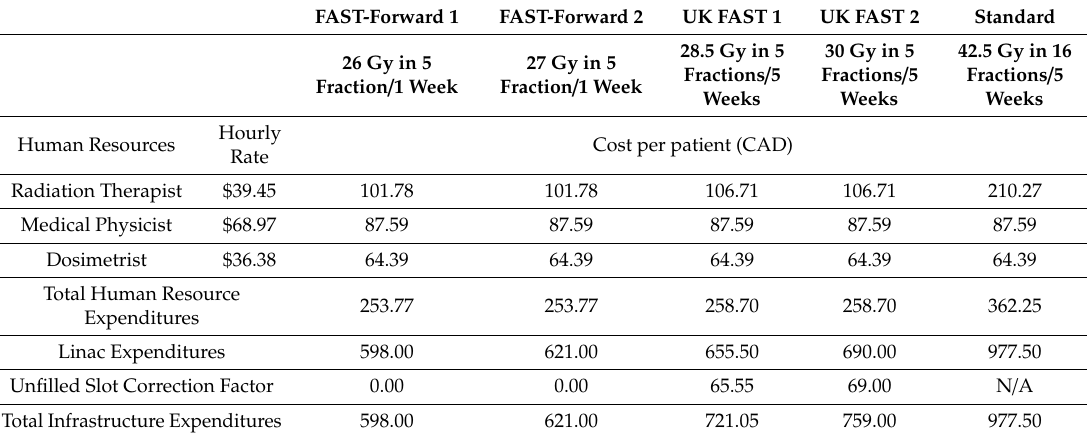
Table 2. Summary of human resource and infrastructure